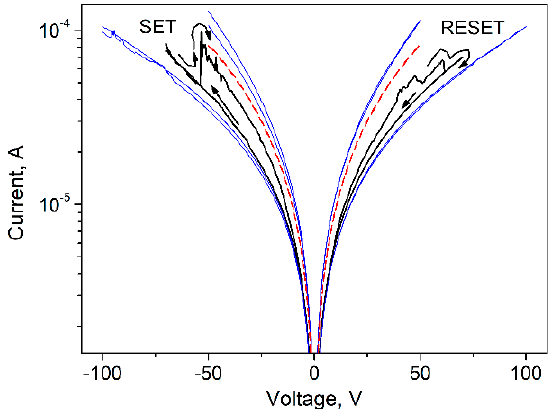
Figure 7. Semi-log plot of the IV curve for CNP-TiO 2 film with sweep range of [ − 70 V, 70 V] (black line) and the two runs, [ − 50 V, 50 V] and [ − 100 V, 100 V], measured immediately before and after it (blue lines). The dashed red line shows the IV curve measured for CNP film in the range [ − 50 V, 50 V].